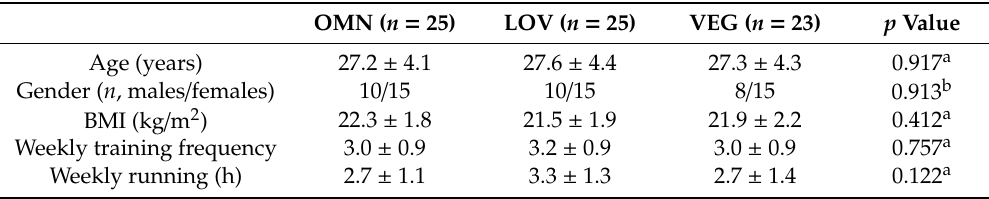
Table 1. Characterization of the study populations.